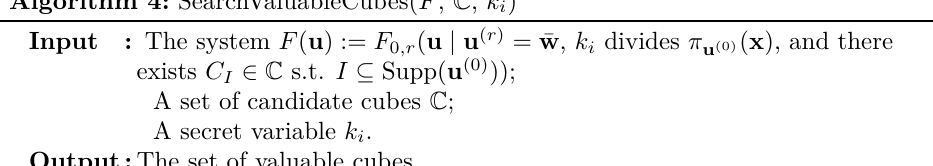
Algorithm 4: SearchValuableCubes( F , C , k i )